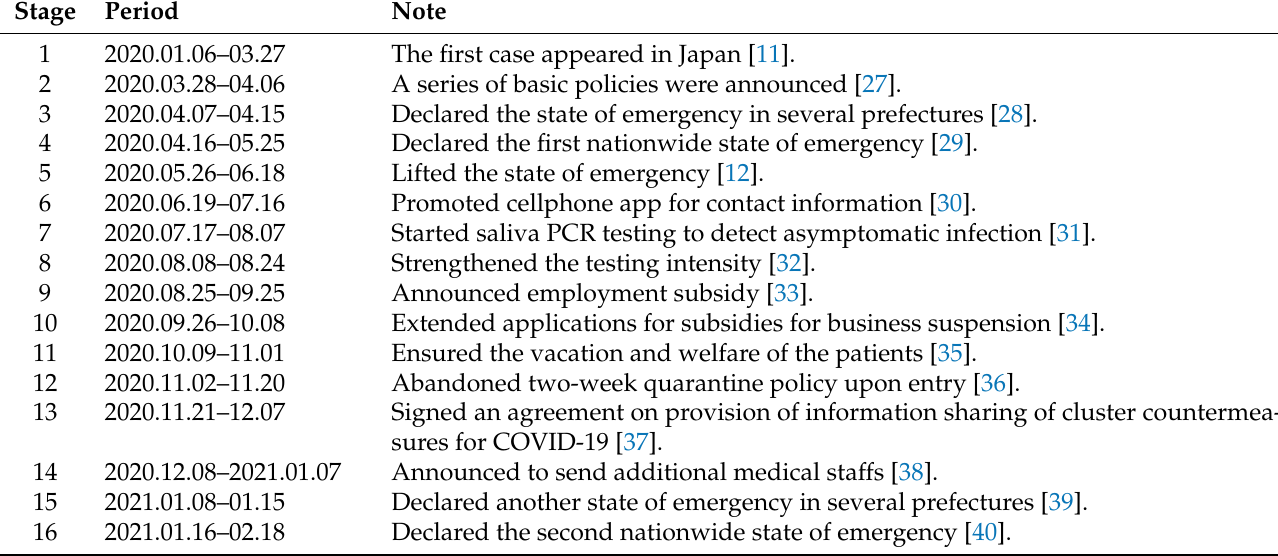
Table 1. The stages of the spread of COVID-19 in